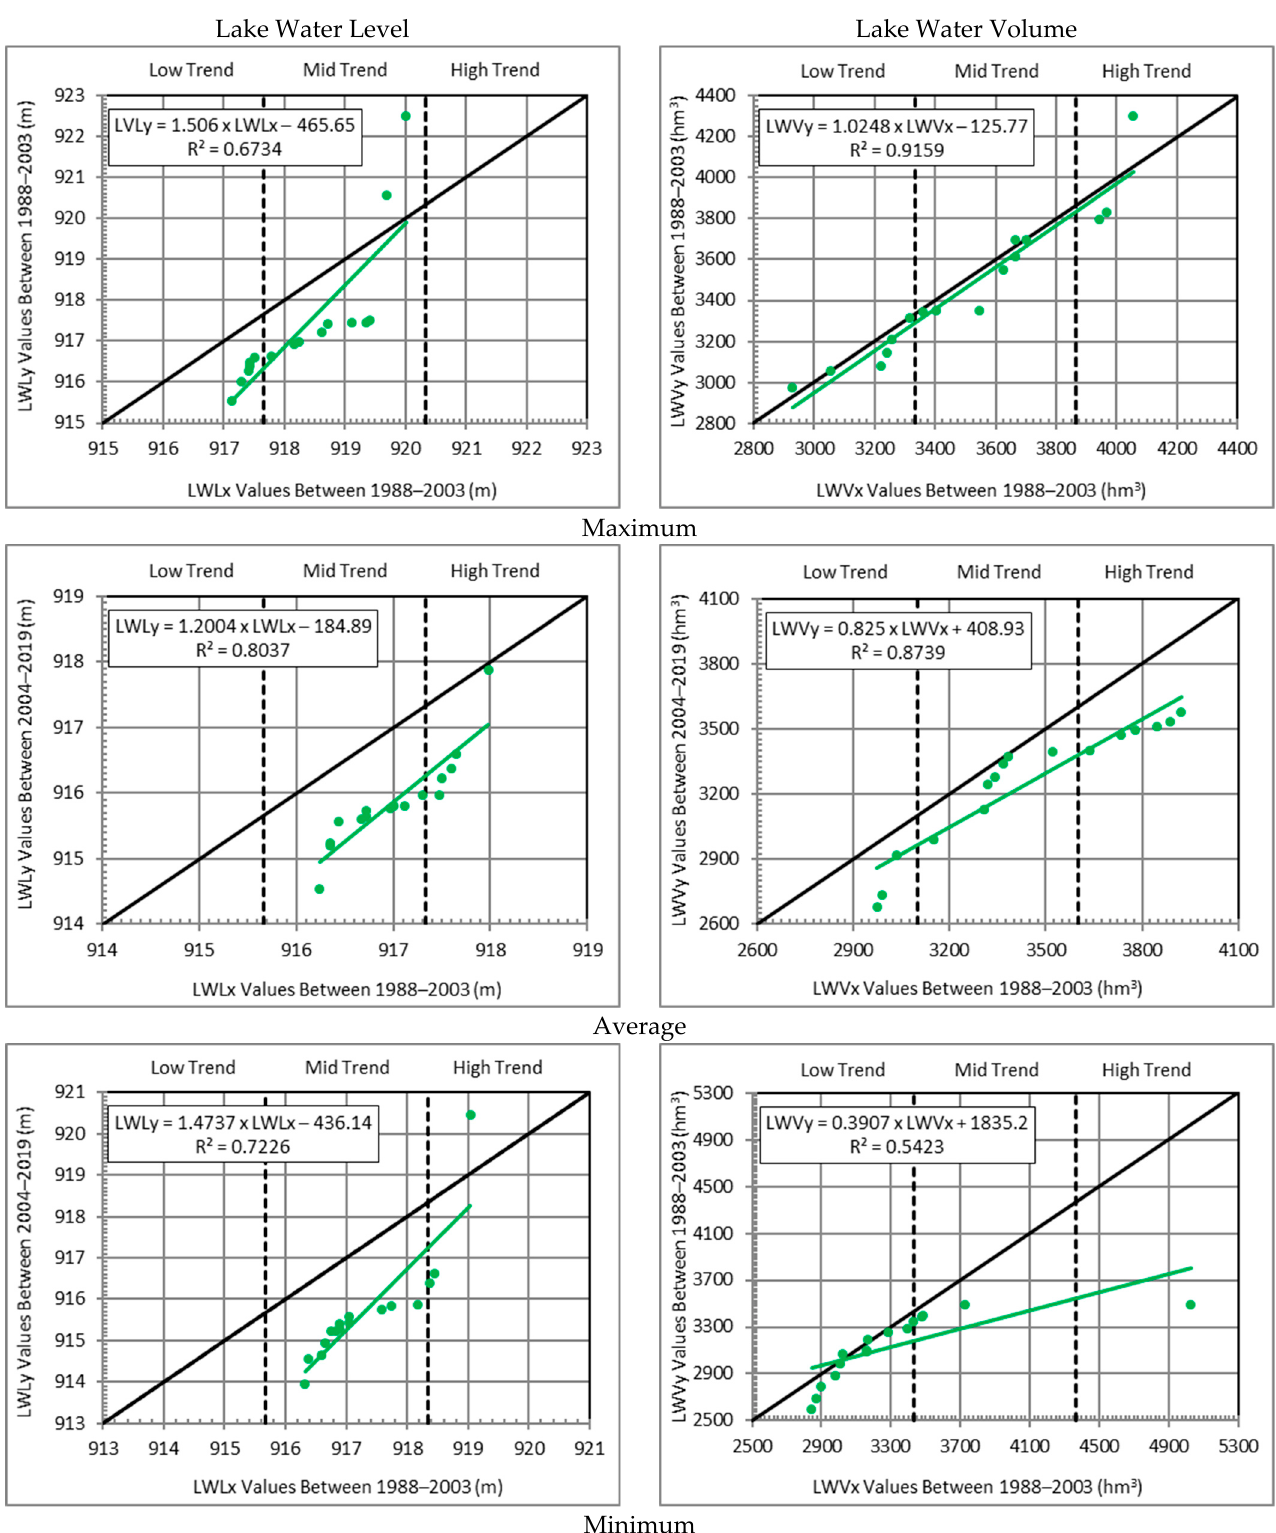
Figure 8. Ş en innovation trend test for the annual LWL and LWV series. Dashed lines were used to show the trend levels (low, medium, and high) in each LWL and LWV series. Green dots were used to show a low trend in the minimum LWV series.